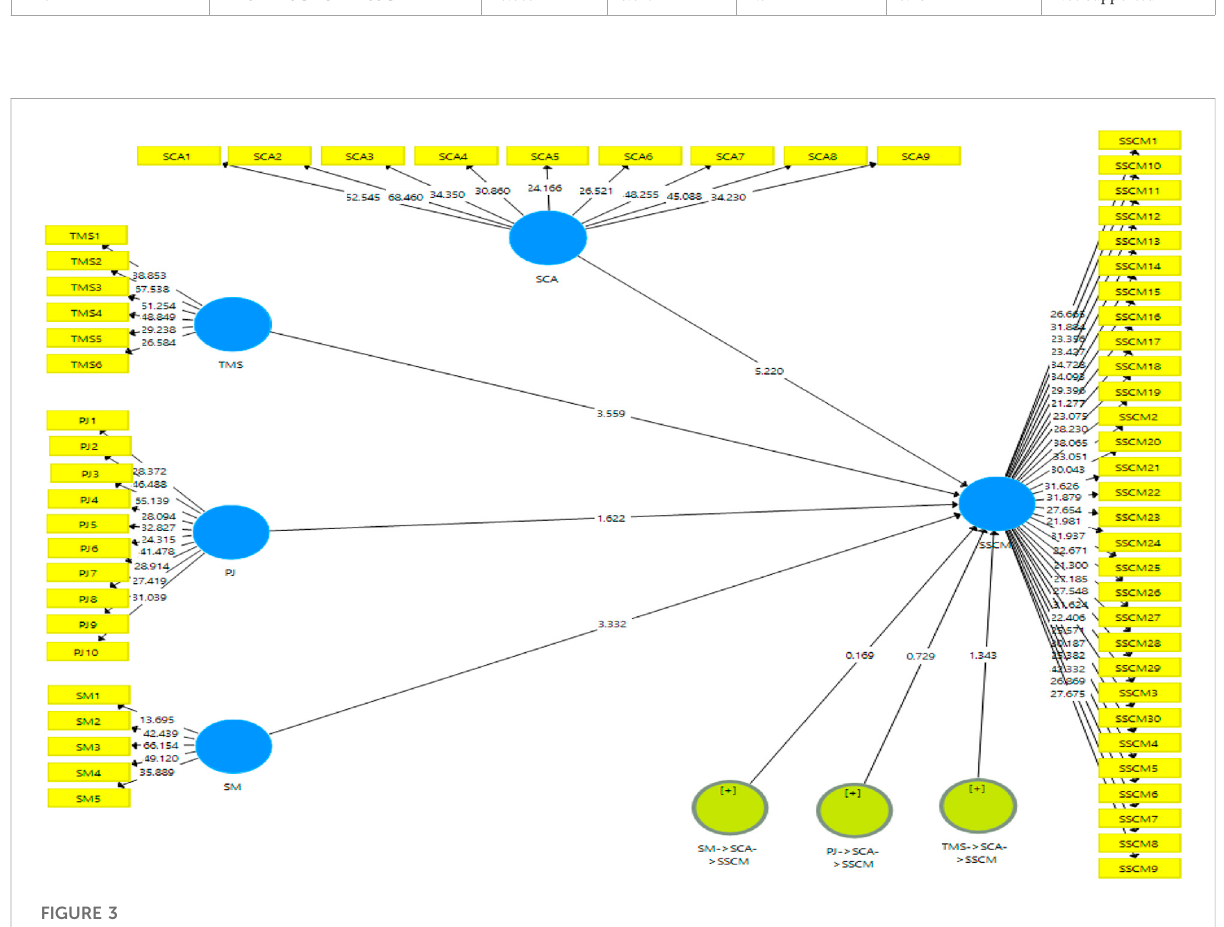
FIGURE 3 Structural model of